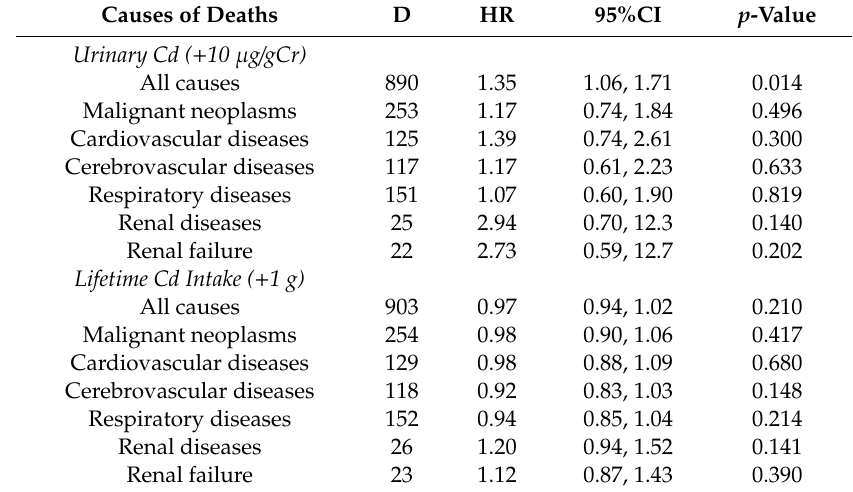
Table 2. Dose–response relationships between hazard ratios and Cd exposure markers in men. Causes of Deaths D HR 95%CI p -Value Urinary Cd ( + 10 µ g / gCr) All causes 890 1.35 1.06, 1.71 0.014 Malignant neoplasms 253 1.17 125